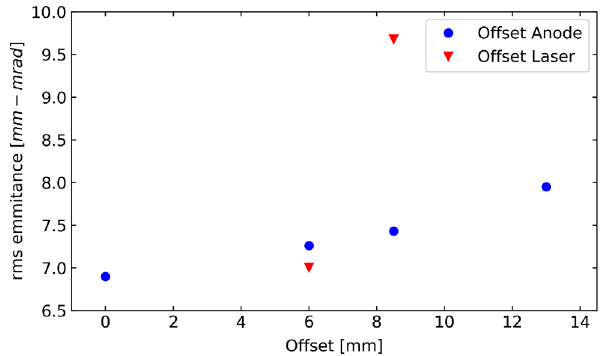
FIG. 9. Normalized r rms emittances ( ϵ (cid:3) r ) for all offset anode and laser cases after compensation by the